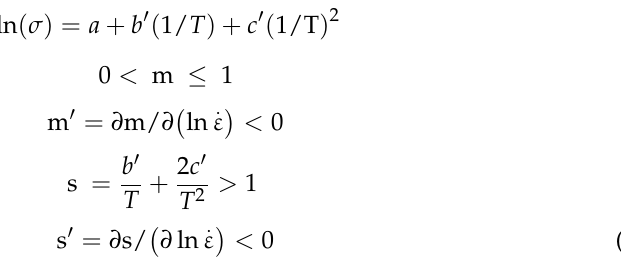
Figure 9. ln(strain rate) variation as a function of inverse temperature.